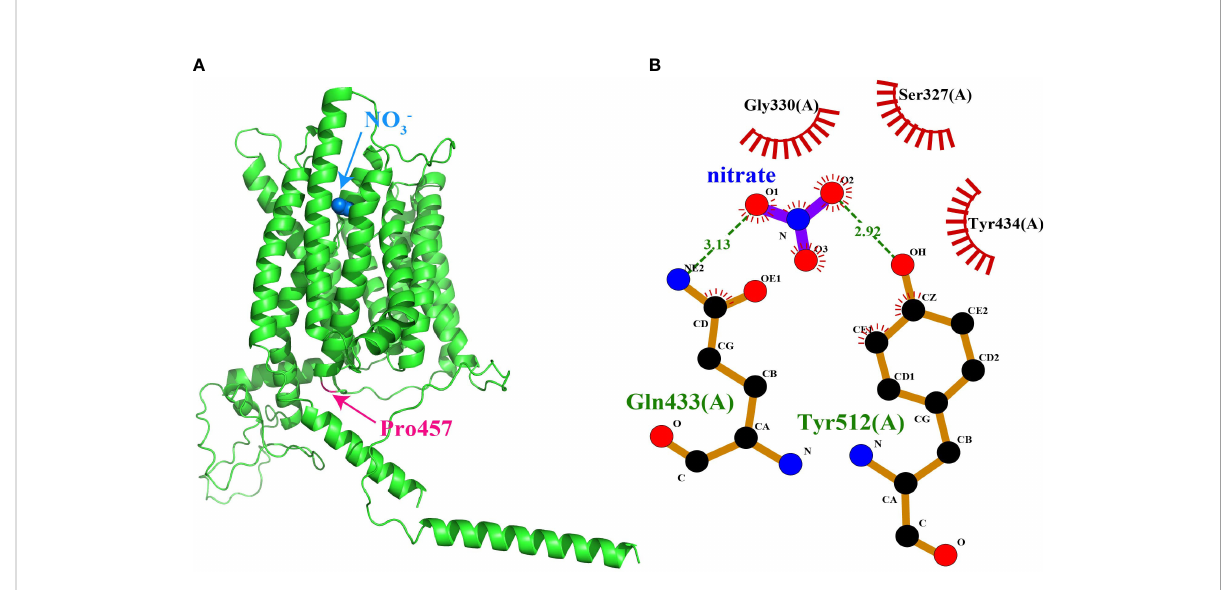
FIGURE 7 Binding model of Si8G11510 to nitrate by molecular docking. (A) The 3D Si8g11510-nitrate interaction model. The conserved Pro457 was marked in pink. (B) The 2D Si8g11510-nitrate interaction model. Dashed lines indicate a potential interaction between Gln433 and Tyr512 with NO − 3 The 3D and 2D interaction models of the other 91 NPFs could be obtained from Supplementary Data 2 and Supplementary Data 3,